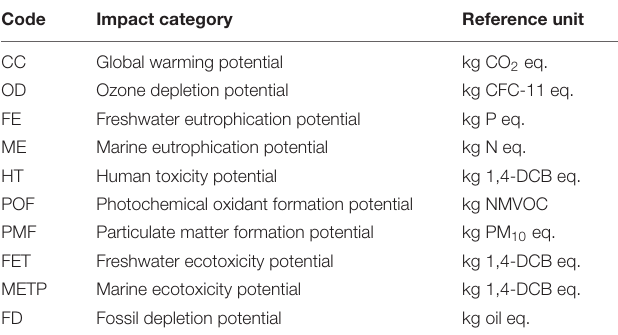
TABLE 3 | Selected impact categories from the impact method ReCiPe Midpoint